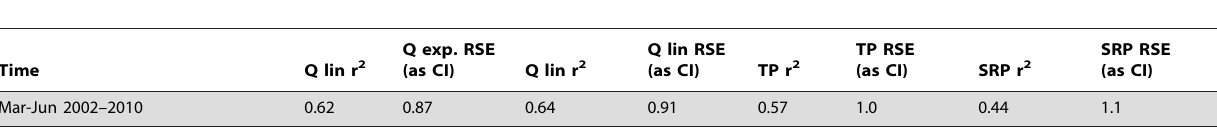
Table 4. R 2 and residual standard error (RSE), excluding 2011 from the analysis. Q exp is exponential relationship, Q lin is linear relationship.